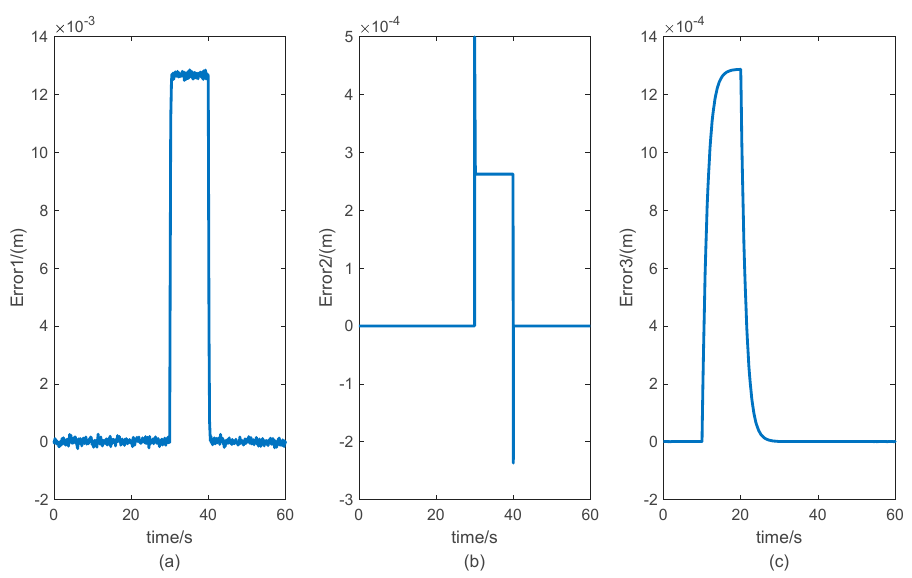
Figure 9. Curves of the error signals with faults (Agent 3). ( a ) Curve of the error signal of Fault 1. ( b ) Curve of the error signal of Fault 2. ( c ) Curve of the error signal of Fault 3.